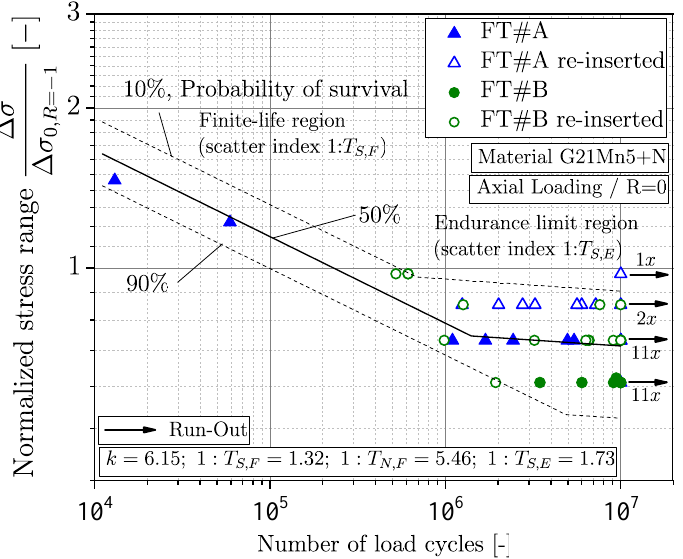
Figure 15. Evaluated S-N curve of the investigated large-scale specimens at R =